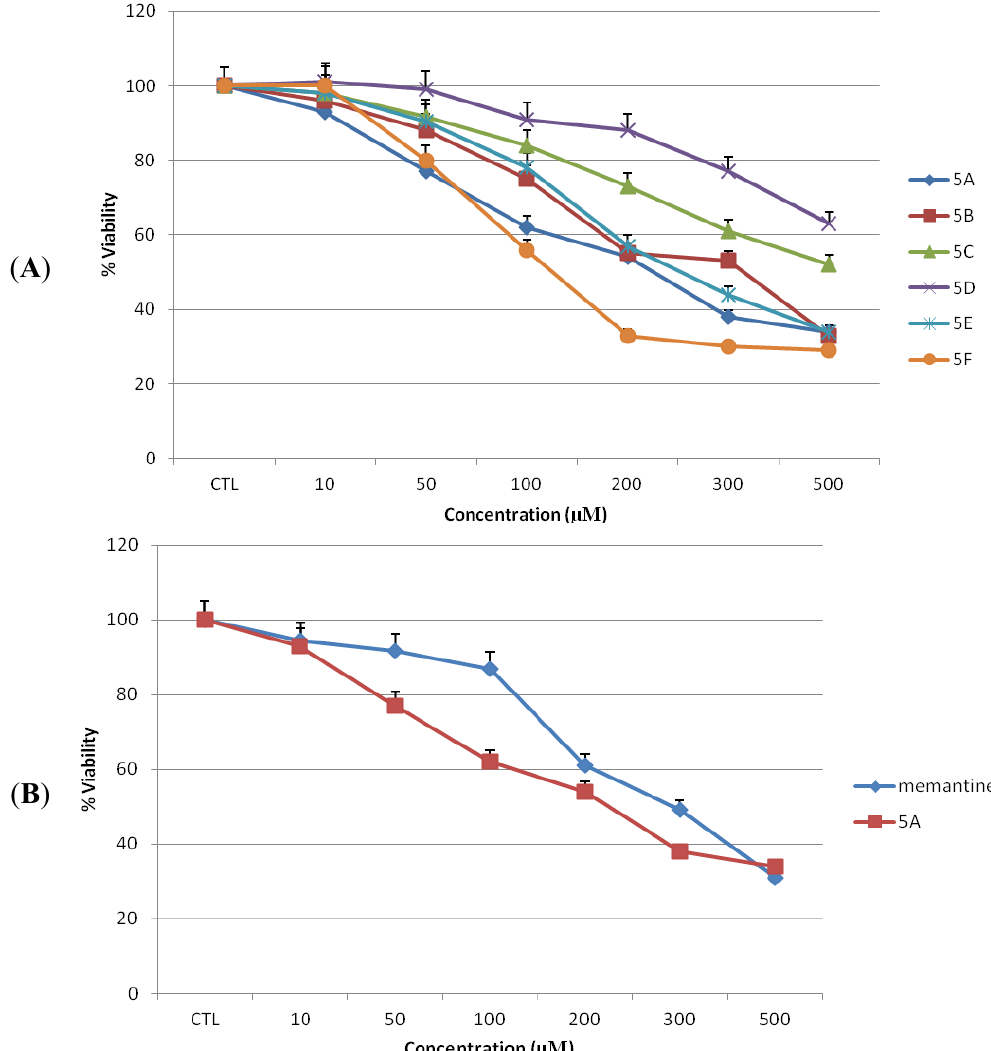
Figure 4. Toxicity of novel NMDA receptor antagonists and memantine on N2a cells. Toxicity (as percentage of untreated control) was measured by MTT assay after 24 h of treatment (n = 3). ( A ) Novel NMDA receptor antagonists 5a – f . ( B ) Lead compound 5a and memantine. All data represent mean ± S.E.M.